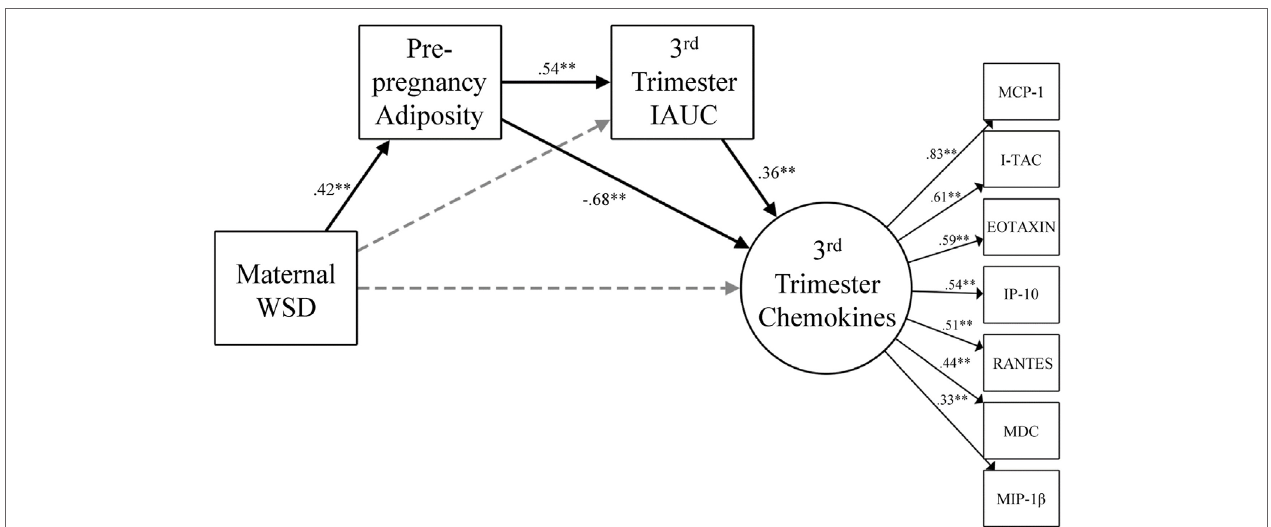
FigUre 3 | Gestational chemokine response and degree of metabolic impairment. The model for chemokine latent variable is presented with constituent chemokine protein markers and the corresponding standardized factor loadings. Paths were also estimated from maternal age at birth to prepregnancy adiposity ( β = 0.53, p < 0.001), third trimester IAUC ( β = − 0.02, p = 0.83), and maternal third trimester chemokines ( β = 0.24, p = 0.04) but were not visually depicted for ease of readability. Black lines indicate significant direct effects ( p < 0.05) and are labeled with β value. See results for further details on model fit and indirect effects. Gray dashed lines indicate paths that were estimated but were not statistically significant. WSD, Western-style diet; IAUC, insulin area under the curve. *p < 0.05 and ** p <